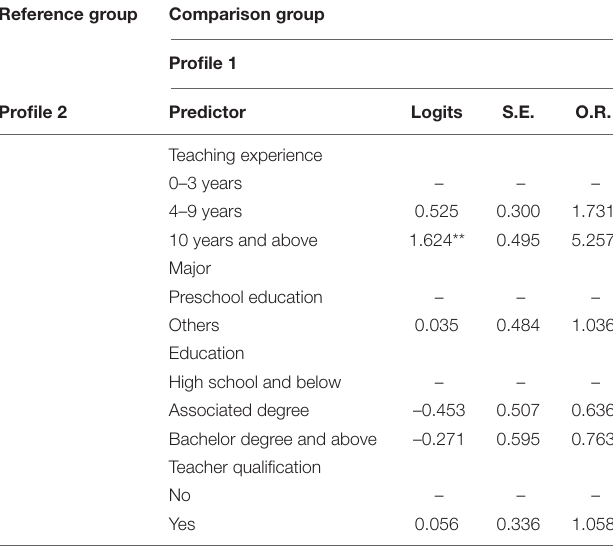
TABLE 5 | Binary logistic regression results of Teacher’s play belief